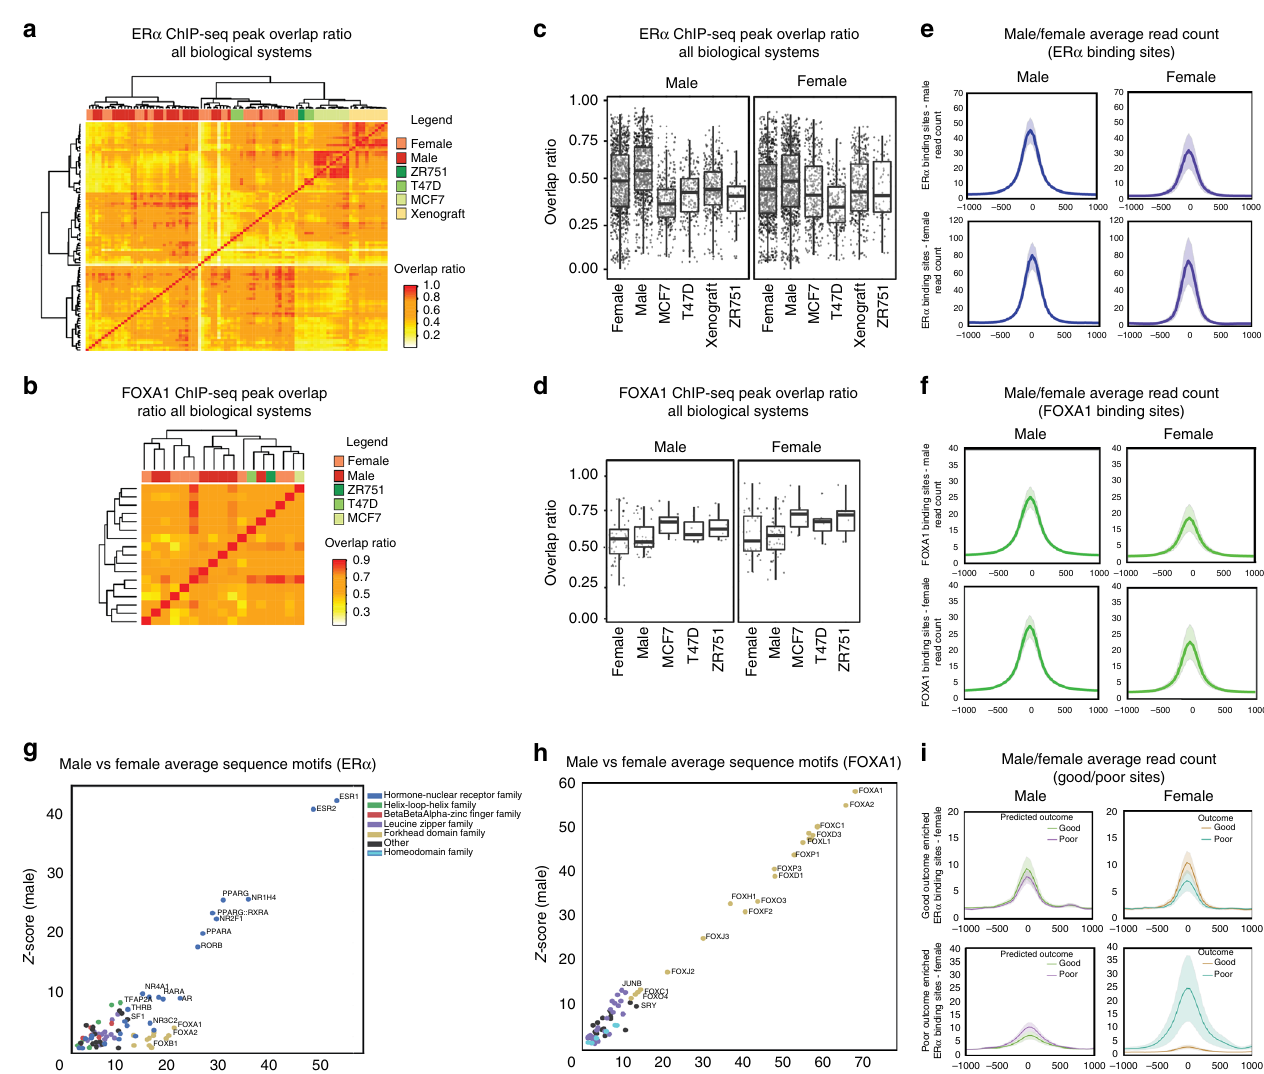
Fig. 5 Strong conservation of ER α and FOXA1 binding between genders. a Correlation plot of ER α bound regions across all biological systems. Top row indicates female tumors (salmon), male tumors (red), and female cell lines ZR751 (dark green), T47D (green), MCF7 (light green) and MCF7 xenograft (yellow) classi fi cation. Overlap ratio is depicted from 0 (white) to 1 (red). b Boxplots depicting all overlap values for ER α bound regions in male (left) and female (right) samples. c Correlation plot of FOXA1 bound regions across all biological systems. Top row indicates female tumors (salmon), male tumors (red), and cell lines ZR751 (dark green), T47D (green) and MCF7 (light green) classi fi cation. Overlap ratio is depicted from 0.3 (white) to 1 (red). d Boxplots depicting all overlap values for FOXA1 bound regions in male (left) and female (right) samples. e Average ER α read count pro fi les for male ER α binding sites (50% consensus, top panel) and female ER α binding sites (50% consensus, bottom panel) in male (left) and female (right) datasets. 75% con fi dence interval of read count pro fi les are indicated with shading. f Average FOXA1 read count pro fi les for male FOXA1 binding sites (50% consensus, top panel) and female FOXA1 binding sites (50% consensus, bottom panel) in male (left) and female (right) data sets. 75% con fi dence interval of average pro fi les are indicated with shading. g Scatter plot depicting Z -scores of signi fi cantly enriched motifs at ER α binding sites in male ( y -axis) and female ( x -axis) tumors. h Scatter plot depicting Z -scores of signi fi cantly enriched motifs at FOXA1 binding sites in male ( y -axis) and female ( x -axis) tumors. i Average ER α read count pro fi les of male (left) and female (right) tumors at the differential ER α binding sites ( ± 5 kb from the peak center) that can discriminate female outcome (top — good outcome enriched; bottom — poor outcome enriched). Patients are grouped based on outcome where indicated color is used for each group. 75% con fi dence interval of average pro fi les are indicated with